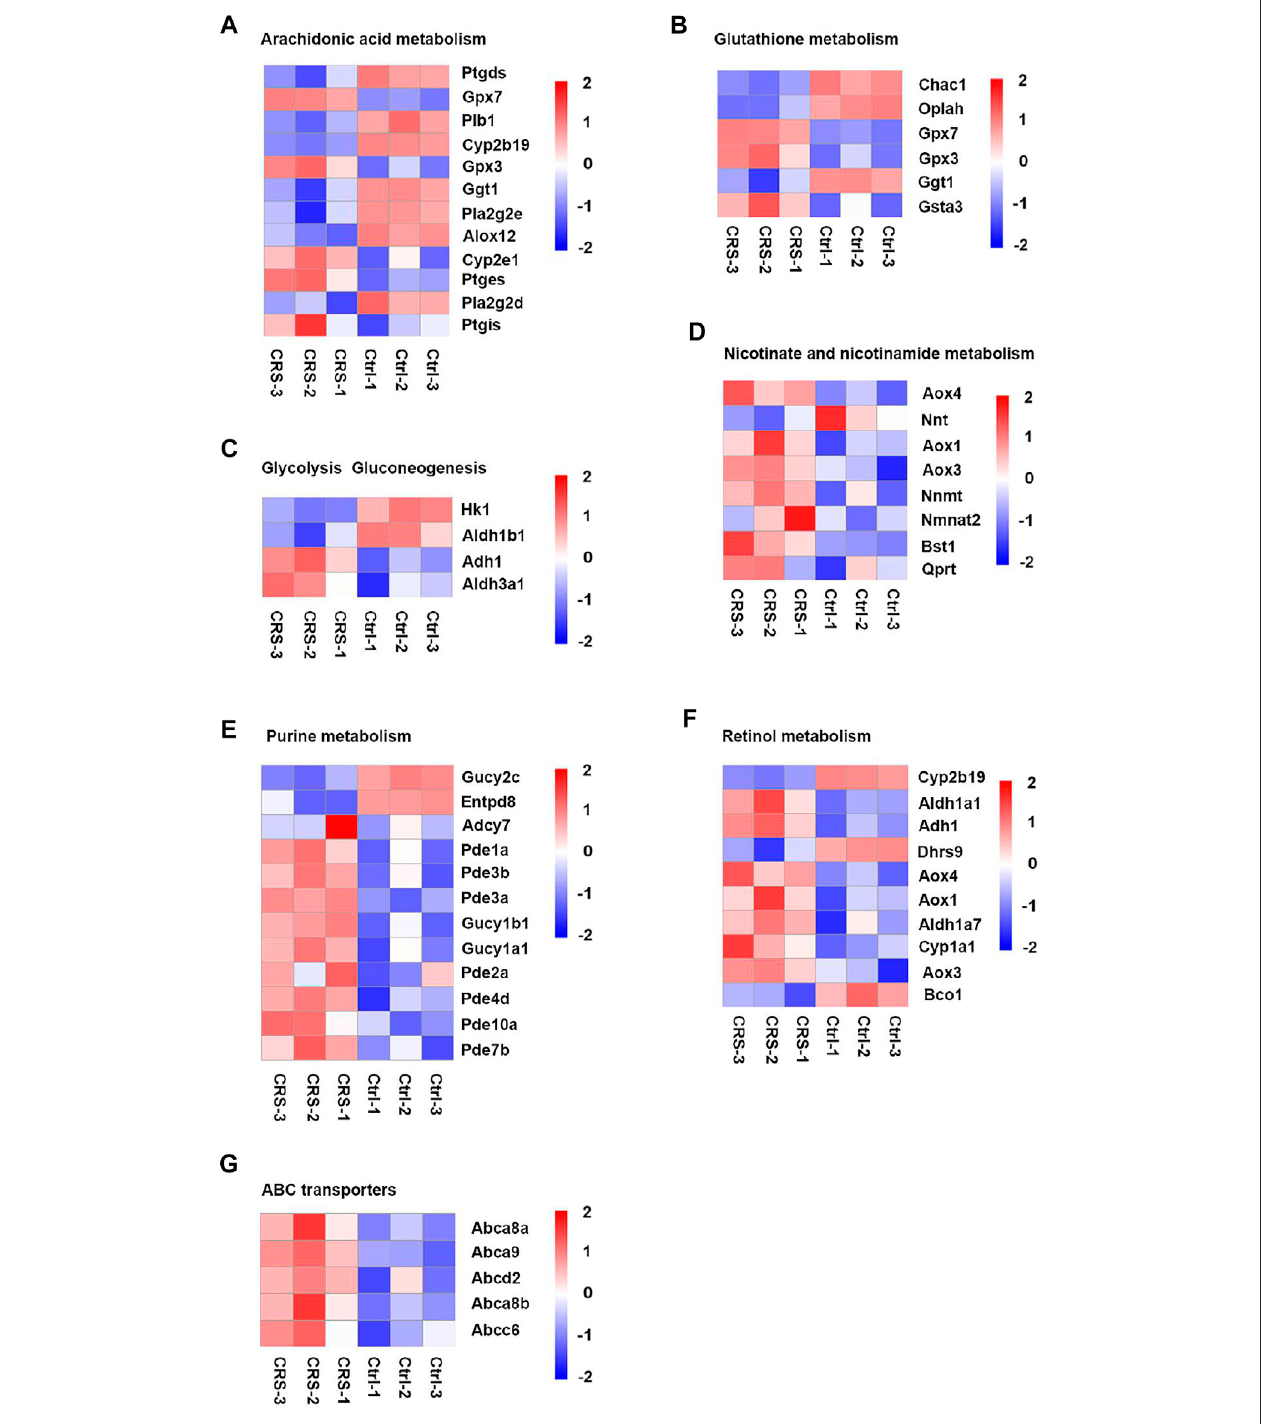
FIGURE 7 | CRS signi fi cantly alters genes expression related to metabolism pathways based on RNA-seq. D. Heatmap analysis showed regulation of genes expression in arachidonic acid metabolism between CRS group and control group. (A) Heatmap analysis showed regulation of genes expression in glutathione metabolism between CRS group and control group. (B) Heatmap analysis showed regulation of genes expression in glycolysis gluconeogenesis between CRS group and control group. (C) Heatmap analysis showed regulation of genes expression in nicotinate and nicotinamide metabolism between CRS group and control group. (D) Heatmap analysis showed regulation of genes expression in purine metabolism between CRS group and control group. (E) Heatmap analysis showed regulation of genes expression in retinol metabolism between CRS group and control group. (F) Heatmap analysis showed regulation of genes expression in ABC transporters between CRS group and control